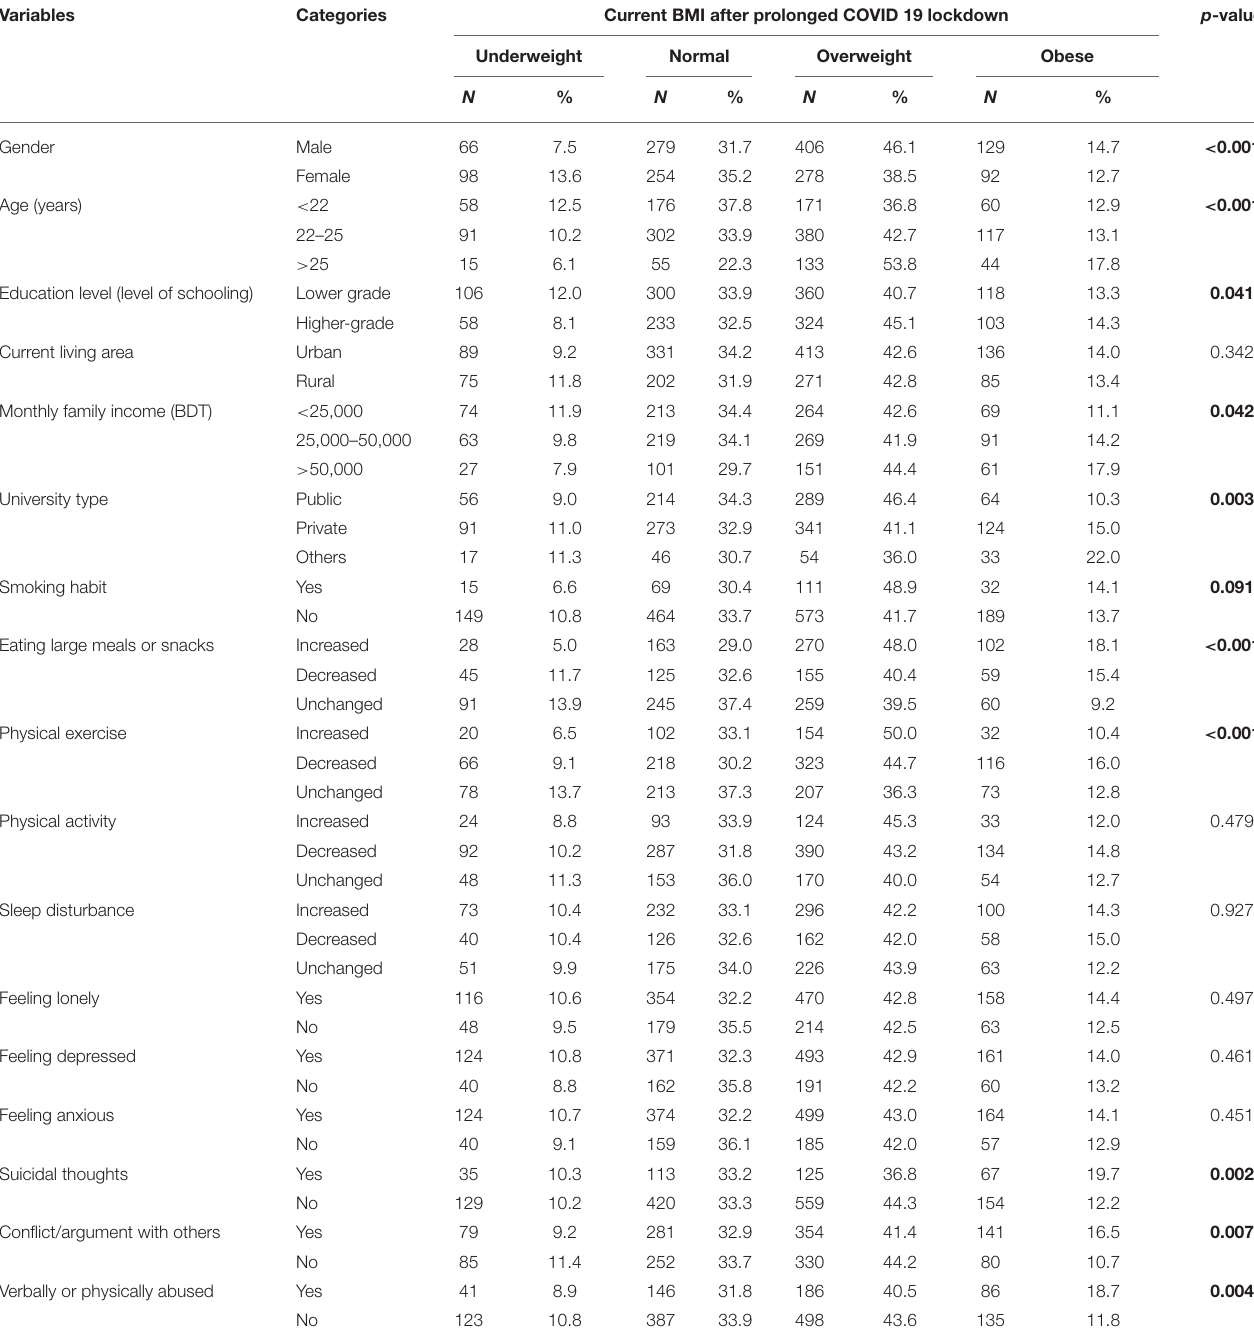
TABLE 2 | Chi-square ( χ 2 ) test for finding potential association of sociodemographic and several physical, psychological, and interpersonal behavioral factors with the degree of body mass index (BMI) among university students following prolonged COVID-19 lockdown in Bangladesh ( N = 1,602).